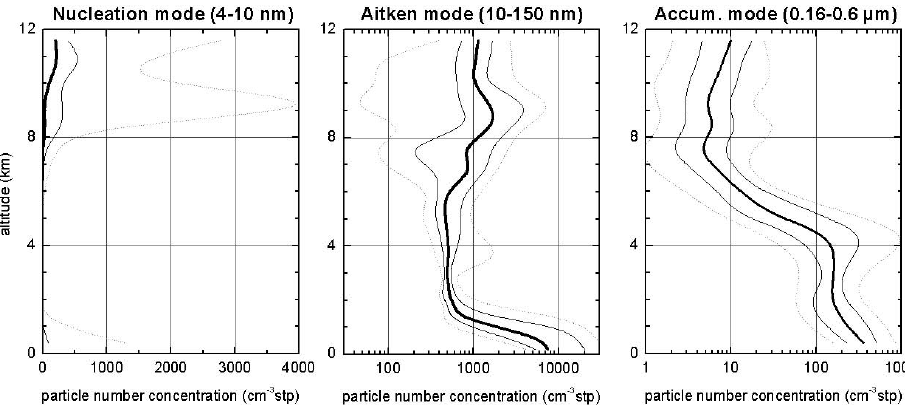
Fig. 16. Vertical distribution of aerosol number concentrations of nucleation mode (approx. 4–10nm particle diameter; left panel), Aitken mode (approx. 10–150nm particle diameter; middle panel), and accumulation mode (approx. 160–600nm; right panel) over the Sahel region from D-F20 flights in August 2008. Only data between 7 and 20 ◦ northern latitude and out of clouds are included. Number concentrations refer to standard conditions of 273K and 1013hPa. Statistics are calculated for 800 altitude bins and illustrated as follows: thick line: median; thin line: 25- and 75-percentile; dotted line: 10- and 90-percentile. The left panel does not include 10- and 25- percentile because not significantly different from zero for all